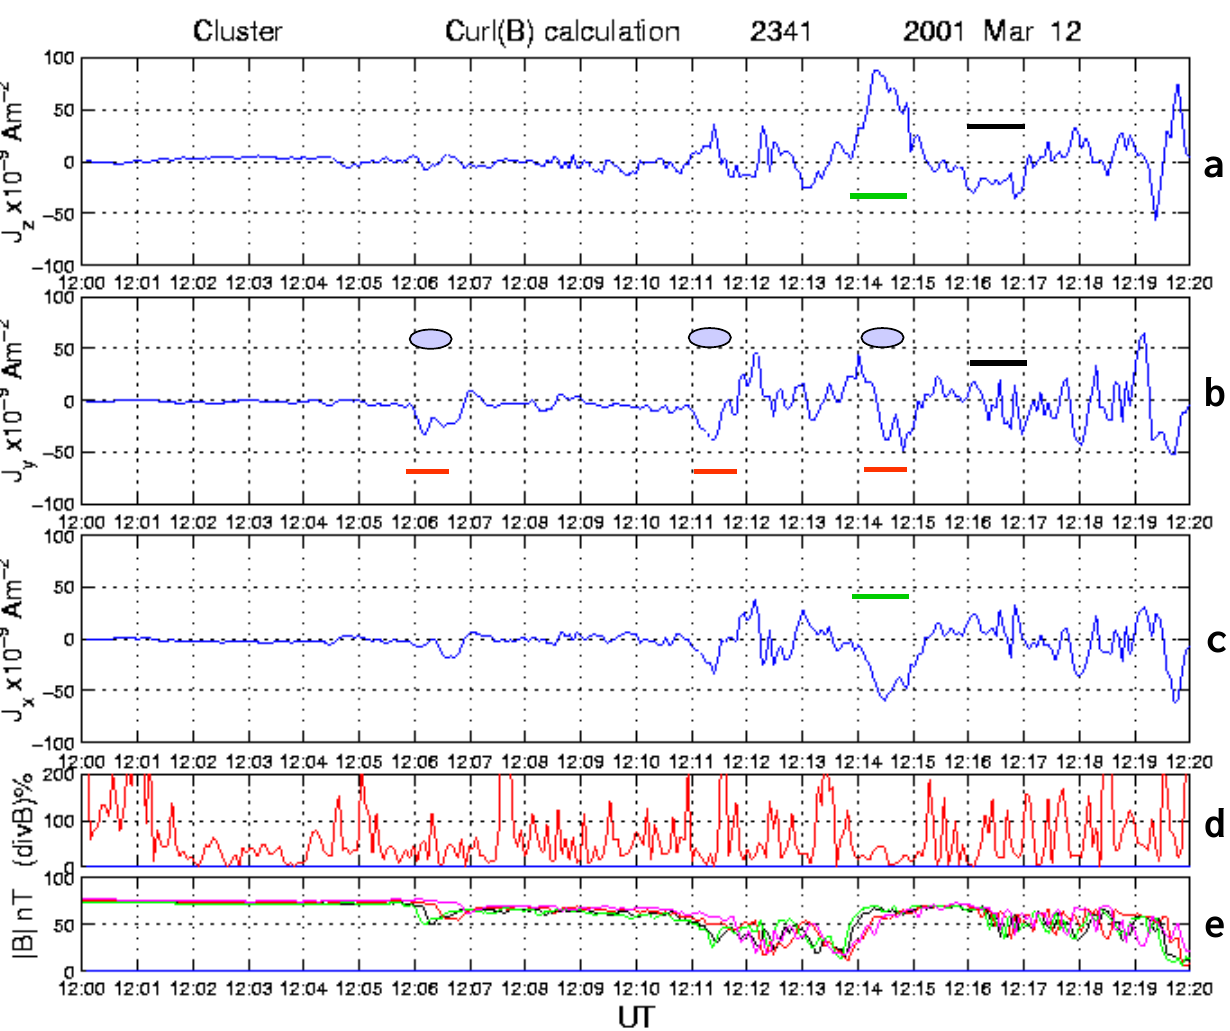
Fig. 15. (a)–(c) Currents in GSM coordinates determined by the Curl B calculation. The calculation is centered on Cluster 2. (d) The ratio of the divergence of B to the curl of B expressed in per cent. The ratio provides an indication of where the calculation is reliable (see text). The magnitude of B is given in the bottom panel for